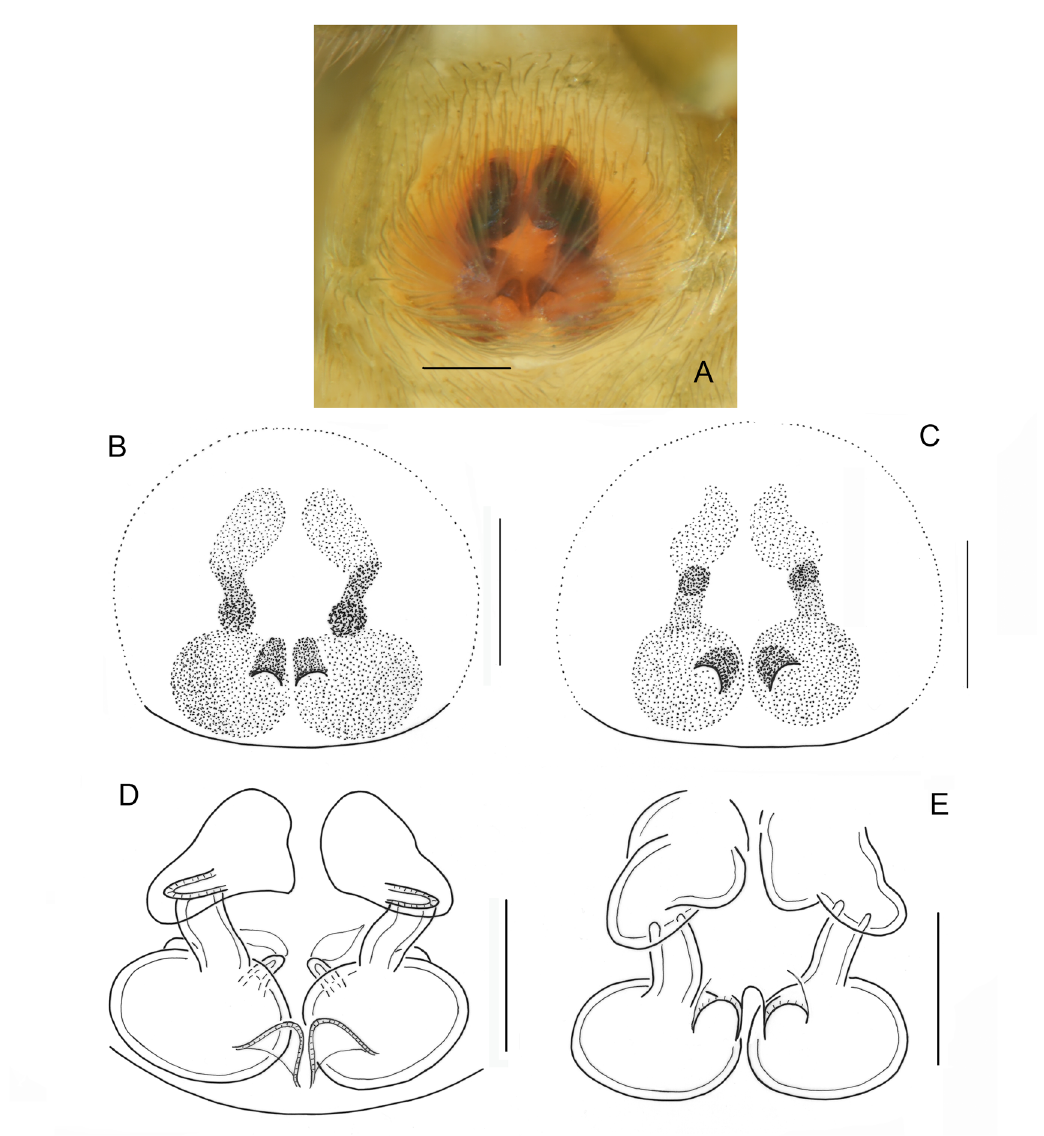
Fig. 2. Pochytoides lamottei sp. nov., paratypes, ♀. A–C . Epigyne. D–E . Internal structure of epigyne. scale bars: 0.2